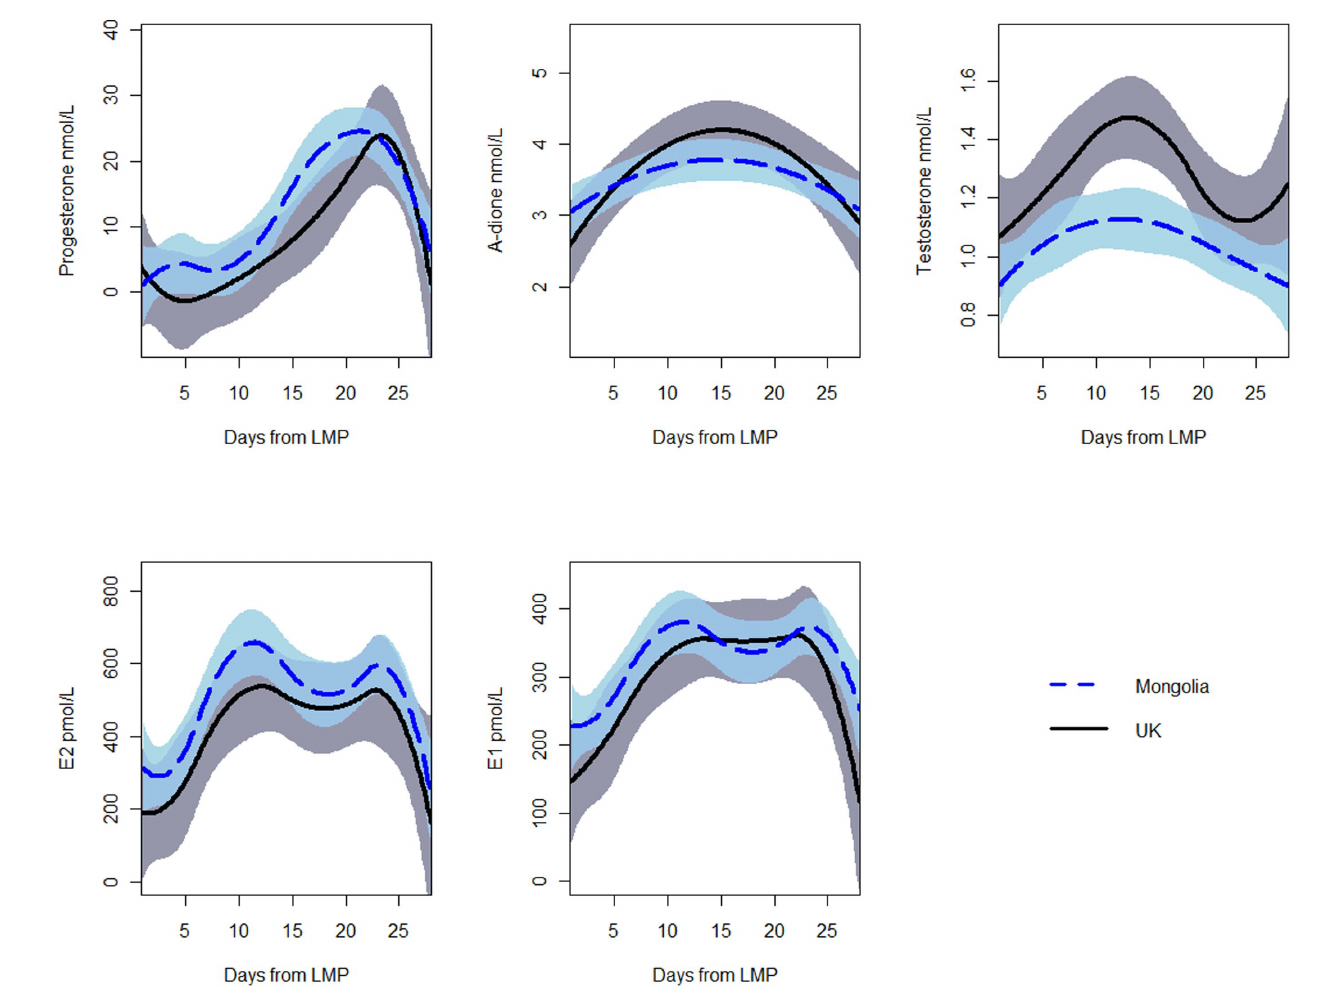
Fig. 1. Hormone concentrations in premenopausal Mongolian and U.K. women, adjusted for age and parity. Dashed lines 5 Mongolia; solid lines 5